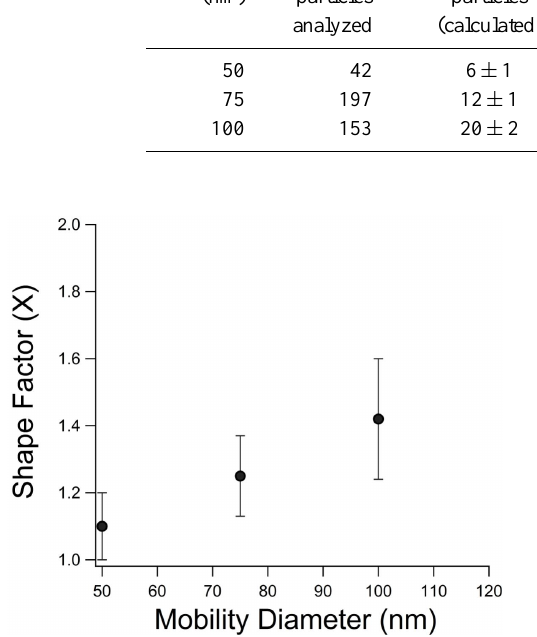
Figure 4. Shape factor ( χ ) vs. the APM selected mobility diameter equivalent for freshly emitted, flaming regime chamise biomass burning aerosol.